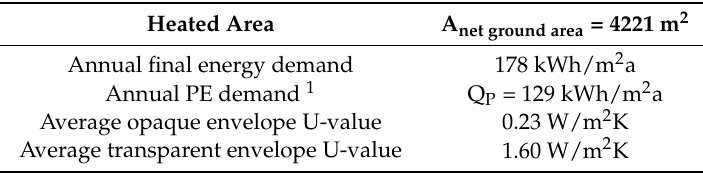
Table A1. Building parameters and indicators for the calculated energy demand following the German Energy Saving Ordinance “EnEV 2009, Energieeinsparverordnung”.